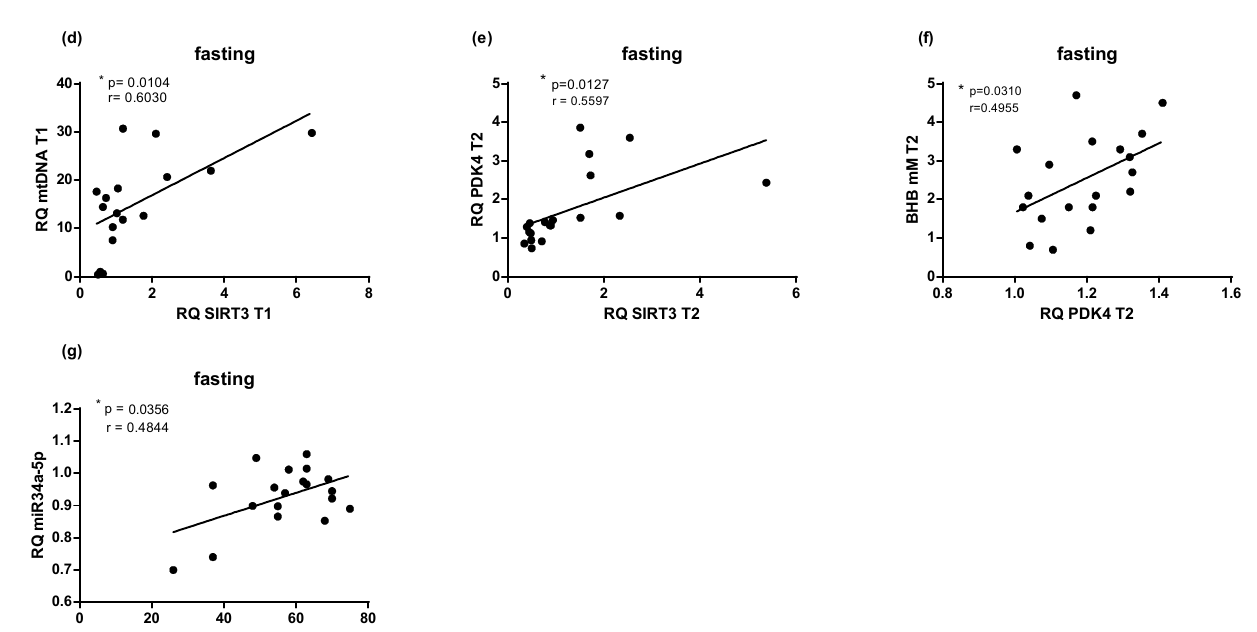
Figure 3. PF results in correlations between gene expression, age, ß-hydroxybutyrate (BHB), and mitochondrial (mt)DNA. Scatterplots illustrate Pearson correlation of different gene expressions with other markers for the fasting population and different timepoints ( a – g ). Statistical significance was defined as a p -value below 0.05.